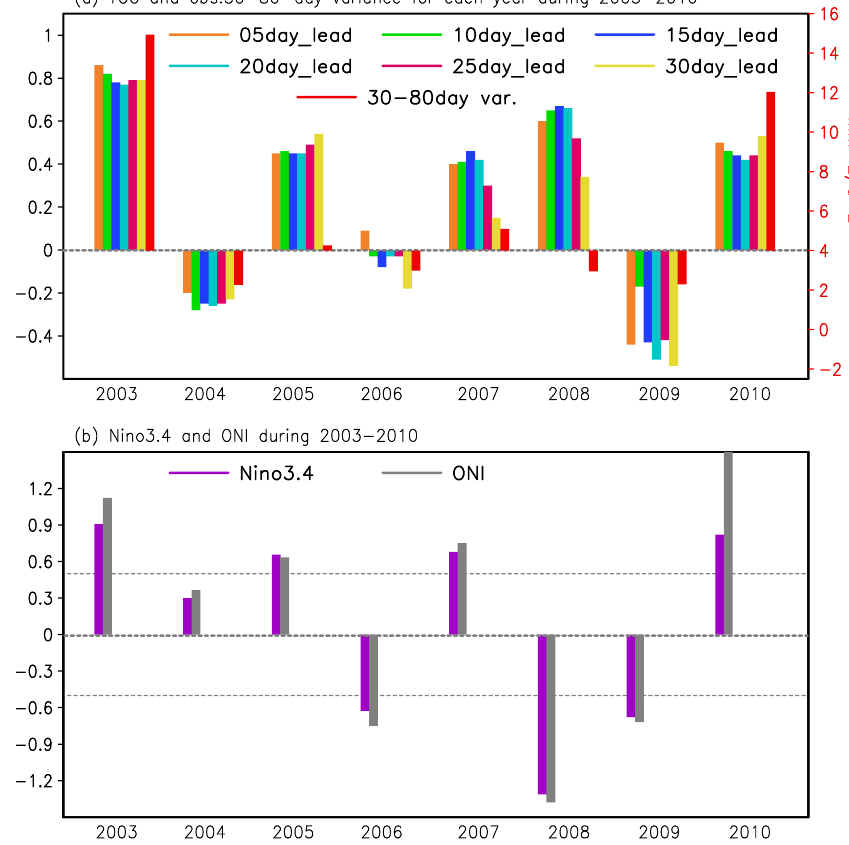
Figure 7. Year-to-year: ( a ) TCCs (left hand y -axis) between the 5–30-day lead forecasted and observed 30–80-day MLRYB rainfall index, along with the variance (right hand y -axis, unit: mm 2 day −2 ) of the 30–80-day MLRYB rainfall index; and ( b ) Niño3.4 Index and Oceanic Niño Index (ONI) (unit: °C), grey dashed lines denote positive or negative 0.5 °C.